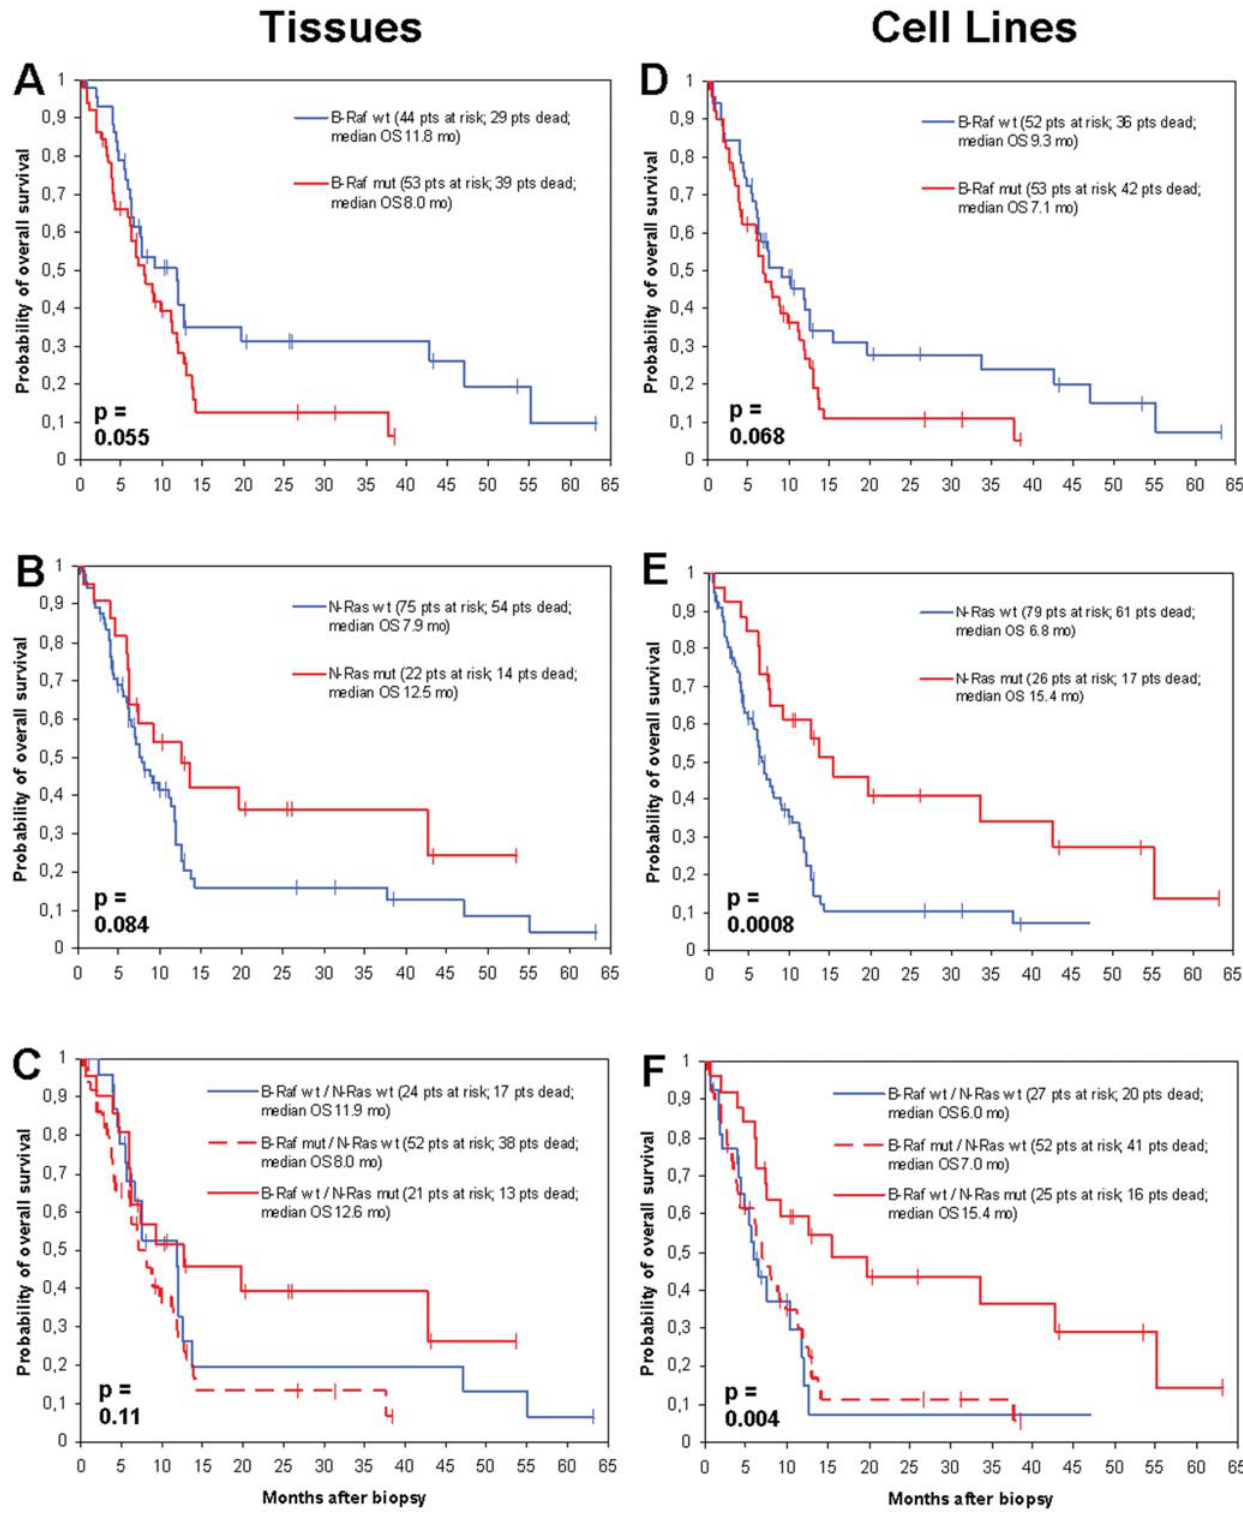
Figure 3. Kaplan-Meier survival estimation for the whole patient population by mutational status. Curves showing the overall survival of 109 metastatic melanoma patients starting from the time point of tumor biopsy. Survival probabilities were compared by the mutational status of B-RAF in tumor tissue biopsies (n=97) (A) and biopsy-derived tumor cell lines (n=105) (D) , as well as N-RAS in tumor tissue biopsies (n=97) (B) and biopsy- derived tumor cell lines (n=105) (E) . (C) and (F) differentiate patients harbouring B-RAF mutations (n=52, tissues; n=52, cell lines), patients harbouring N-RAS mutations (n=21, tissues; n=25; cell lines), and patients without mutations in both genes (n=24, tissues; n=27, cell lines). Statistical differences between groups were calculated using the log-rank test. Vertical bars indicate censored observations. doi:10.1371/journal.pone.0000236.g003 PLoS ONE |